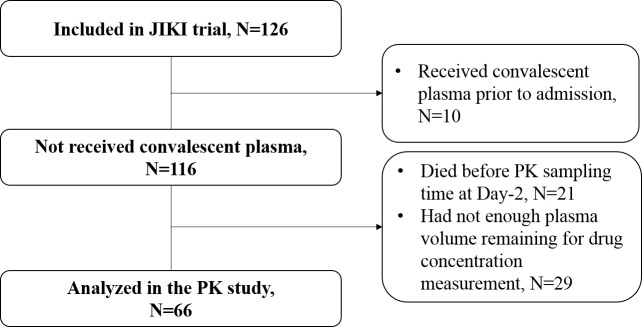
Flowchart of the patients included in the PK analysis of the JIKI trial